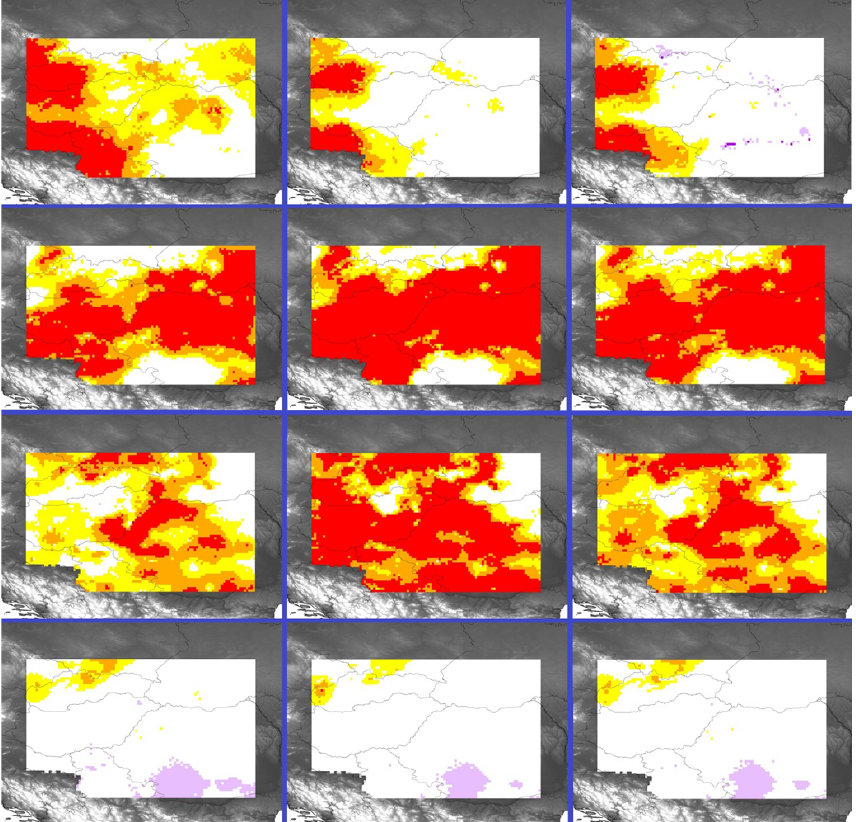
Figure 5. Left to right: SPI-3, SPEI-3, and RDI-3. Top to bottom: April 2003, June 2003, August 2003, October 2003. See Table 2 for colour-scale.